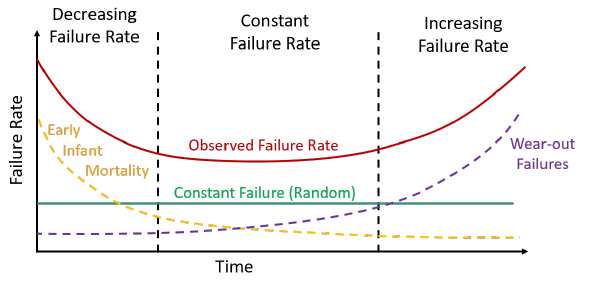
Figure 2. A classical bathtub curve represents common device failure characteristics